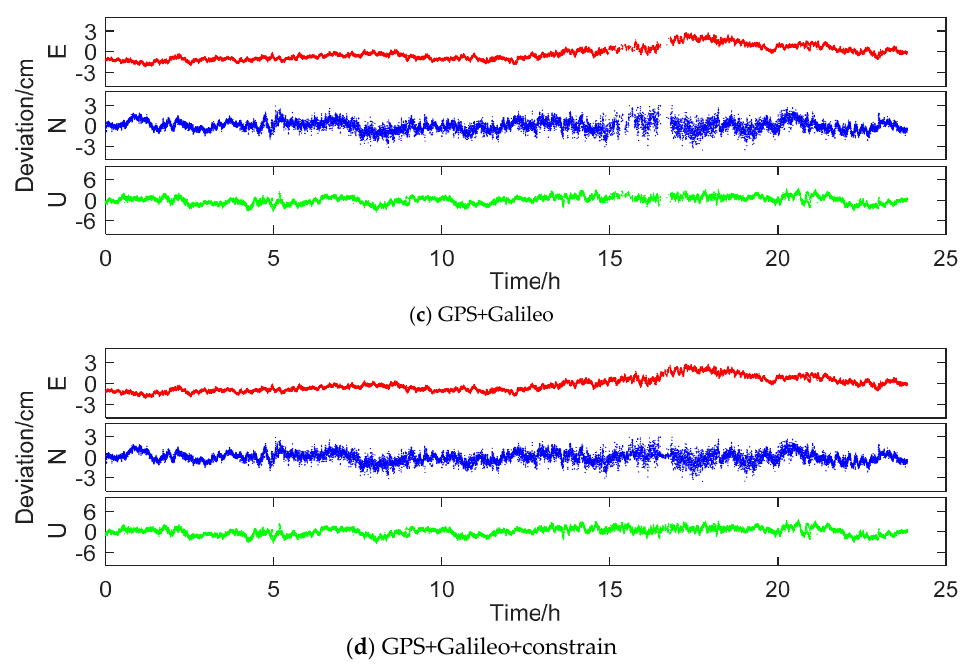
Figure 5. Position deviation of different strategies for baseline shm1-shm4: ( a ) GPS, ( b ) GPS with baseline constraint (C-GPS), ( c ) GPS / Galileo, and, ( d ) C-GPS / Galileo.